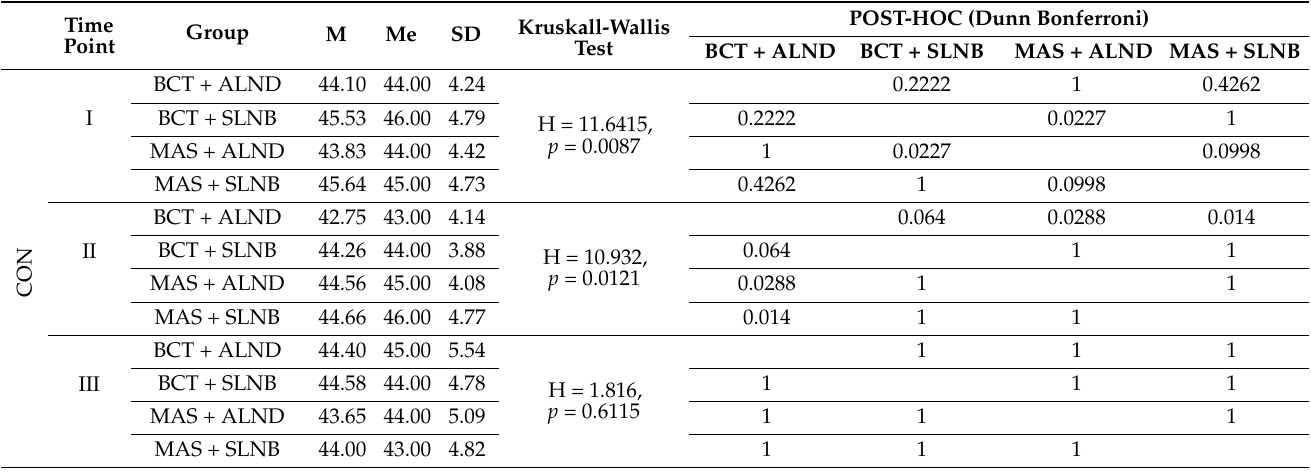
Table 4. Adjustment to life with cancer in breast cancer patients and the relationships between the groups (MAS + SNB, MAS + ALND, BCT + SNB, BCT + SNB) and assessment time points. Time